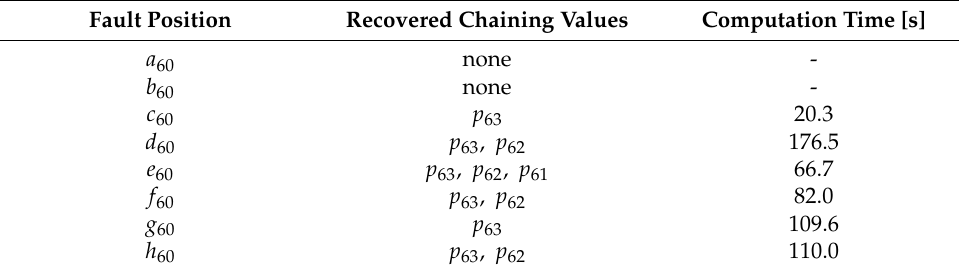
Table 1. Recovered chaining values and computation time.